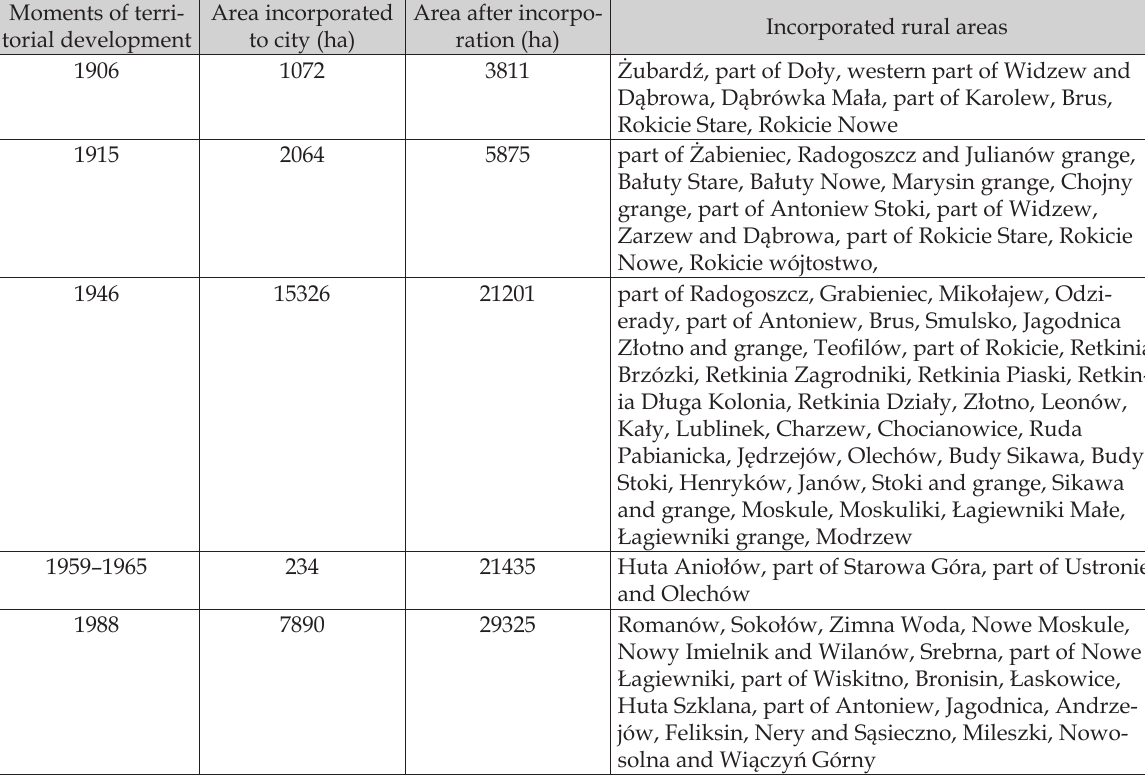
Table 1. Incorporations of rural areas to the city of Łódź in the 20th century. Moments of